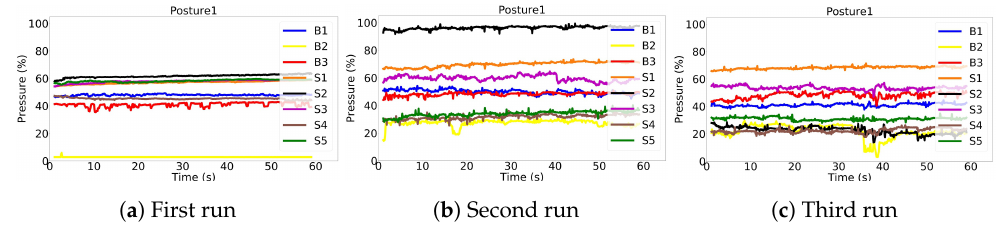
Figure 16. Pressure sensors raw signals during three repetitions of the same subject sitting in Posture 1. The weight distributions of the subject on sensors have different patterns in each repetition, challenging the models in recognizing them as the same